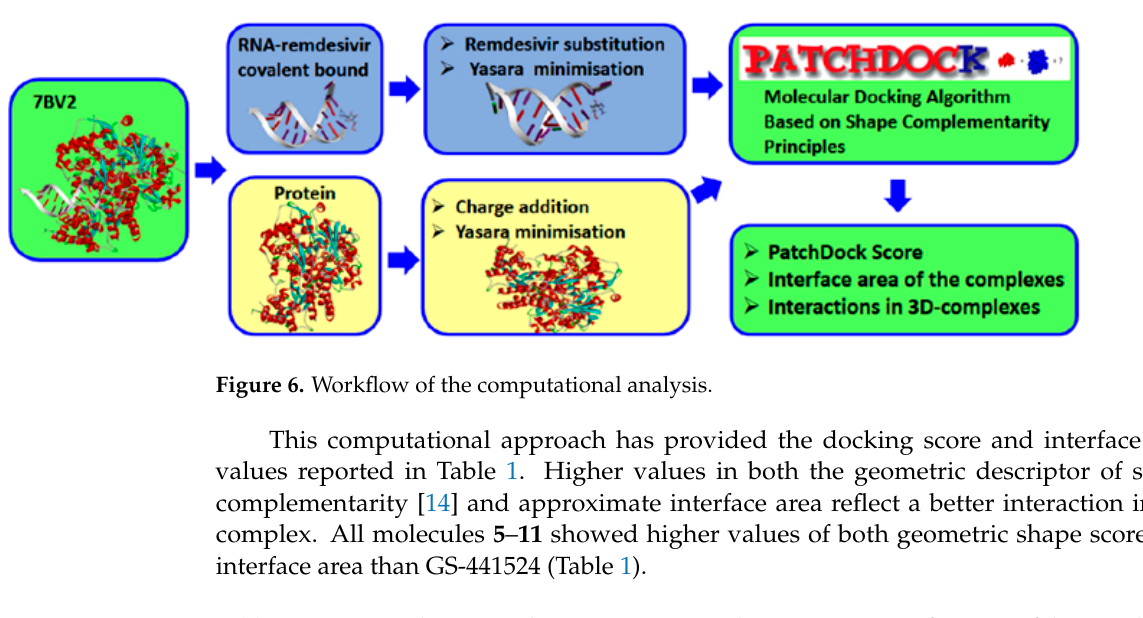
Table 1. Geometric shape complementarity score and approximate interface area of the complex for each indicated compounds with free RdRp (7BV2) by computational analysis described in Figure 6.